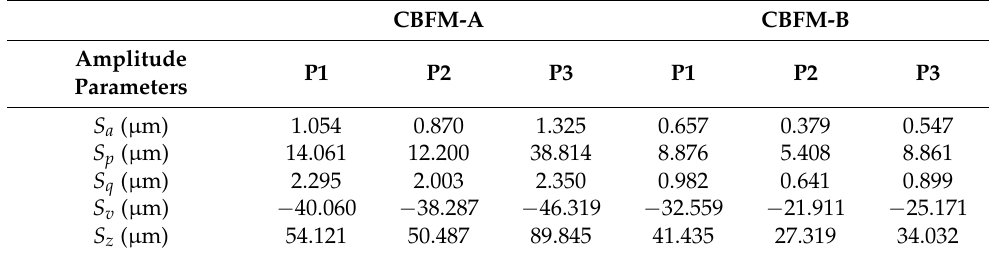
Table 4. Morphology parameters of the post-test surface of CBFM-A and CBFM-B.